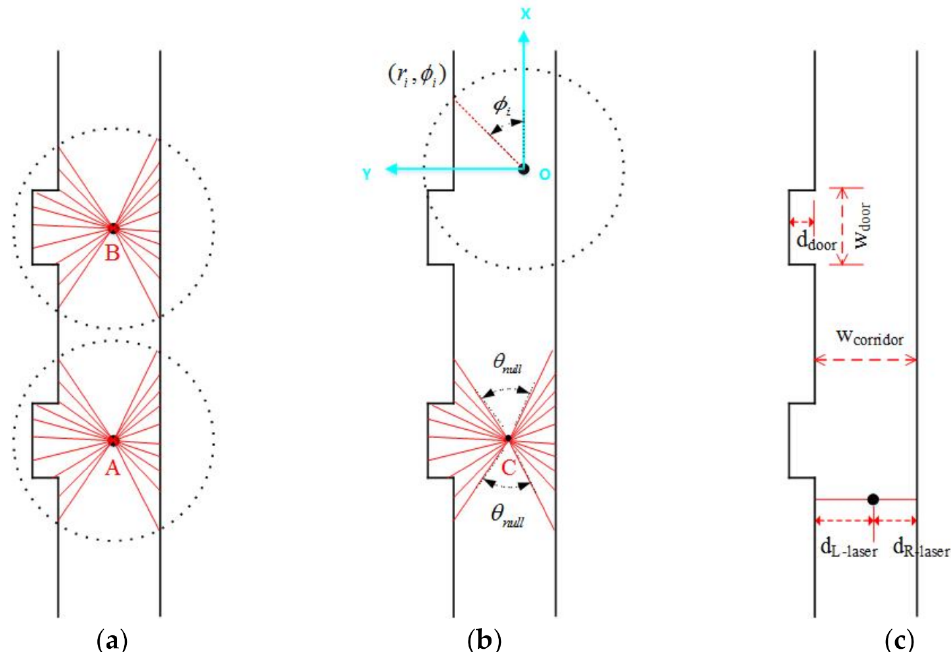
Figure 2. Laser scans in long corridor environment. ( a ) Laser scans in two similar locations; ( b ) Laser data coordinates and scanning result; ( c ) Dimensions of the